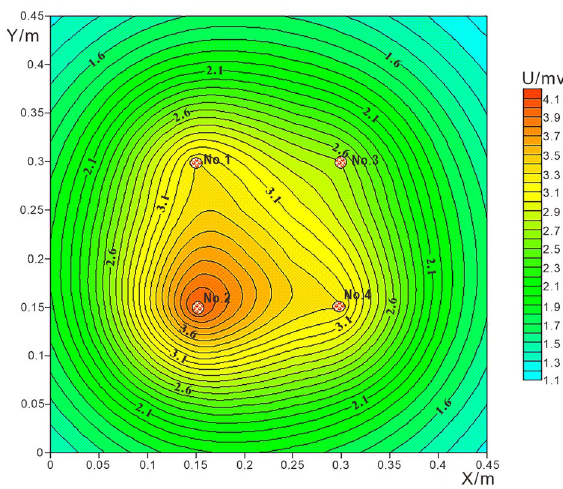
Figure 5. 10 × 10 Grid theory detection potential contour